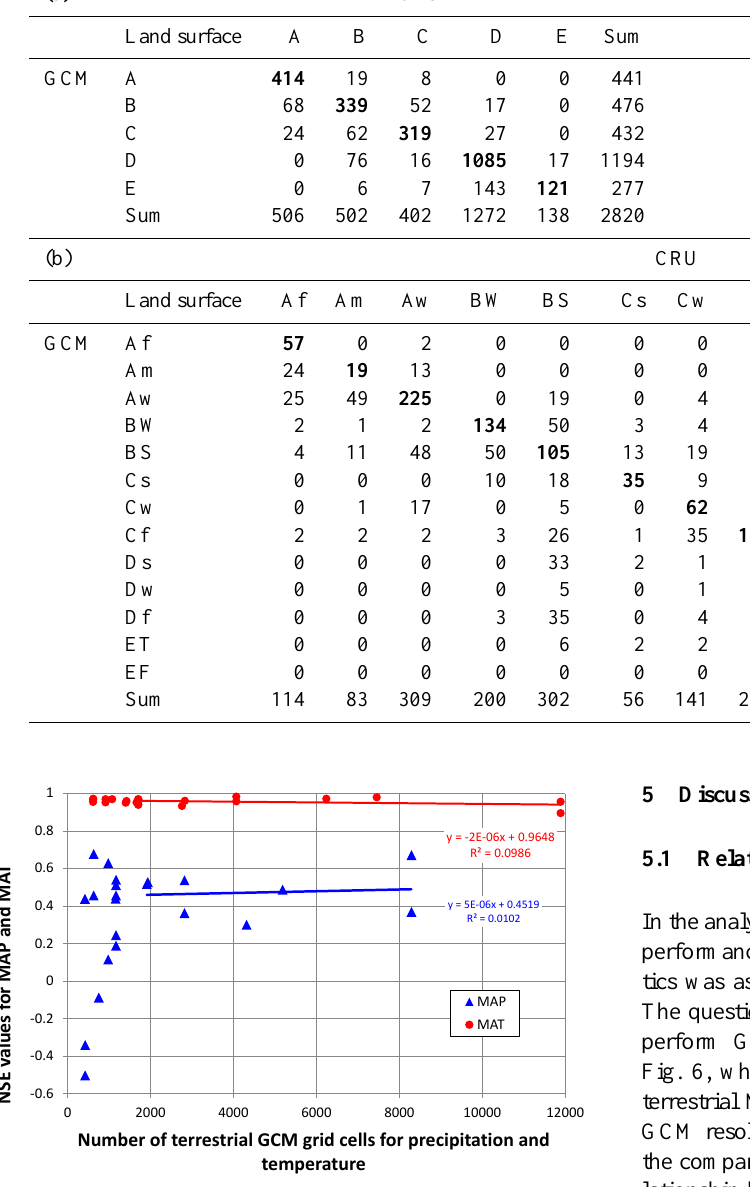
Figure 6. Relating 22 CMIP3 GCM resolutions (as the number of terrestrial grid cells for MAP) to model performance based on Nash–Sutcliffe efficiency (NSE) for mean annual precipitation and mean annual temperature. (The trend lines are fitted to data with > 1500 grid